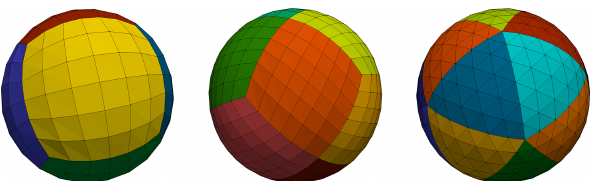
Figure 2. From left to right: HS06, HS12 and HS20 shells coloured by block number.